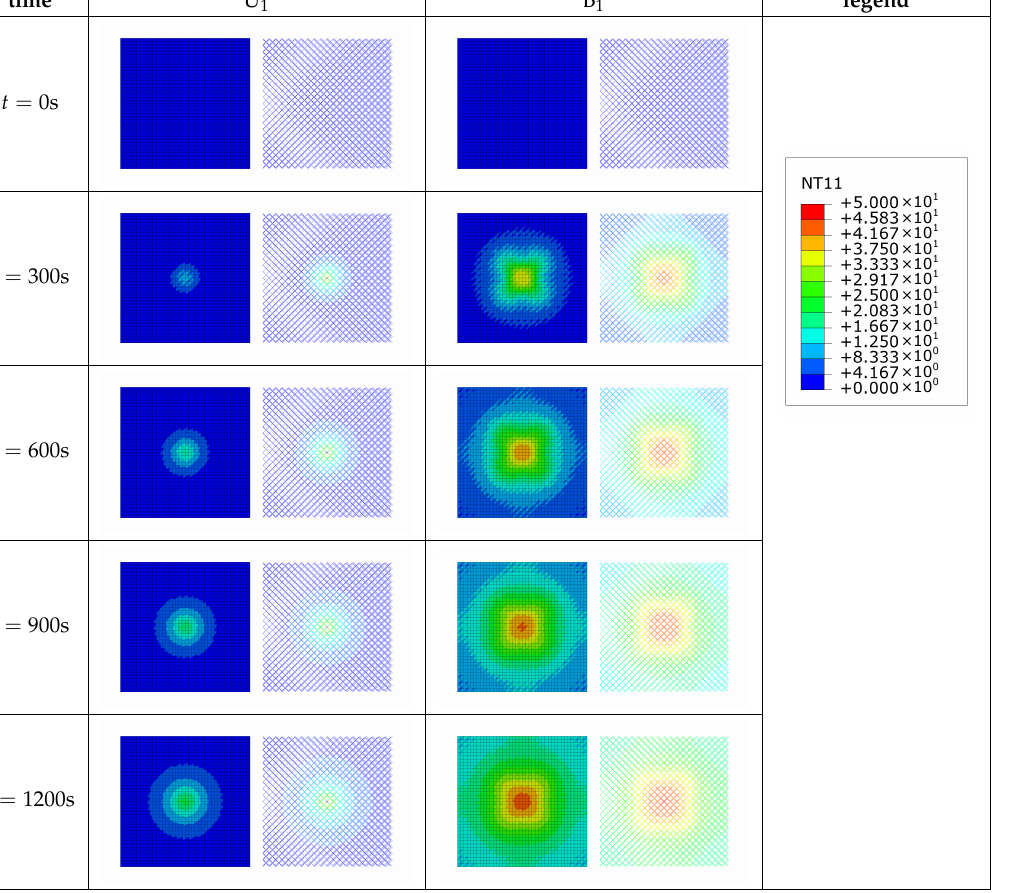
Figure 11. Transient heat transfer process analysis results of U 1 and B 1 under WC 1 .